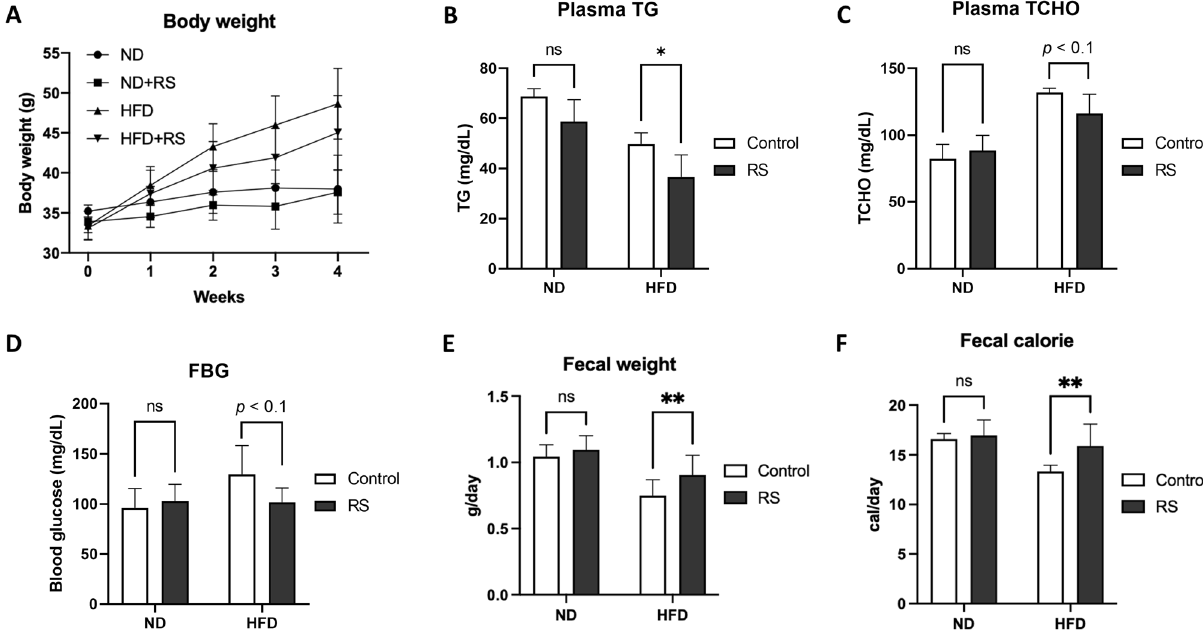
Figure 1. RS decreases blood lipids and increases faecal amount in mice with high fat diet (HFD). ( A ) Body weight change during the feeding experiment. ( B,C ) RS suppression increases in plasma triacylglycerol (TG; ( B )) and total cholesterol (TCHO; ( C )) in HFD-mice at Week 4. ( D ) Fasting blood glucose (FBG) at Week 4. ( E,F ) RS increased in faecal weight ( E ) and faecal calorie ( F ) in HFD-mice during the feeding experiment. * p < 0.05, ** p < 0.01. n = 5, error bars indicate